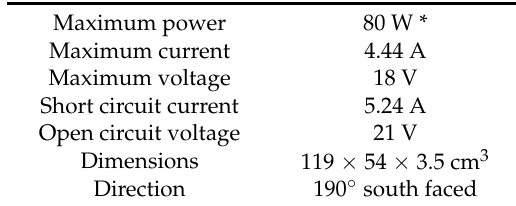
Table 1. Mono-crystalline panel’s parameters.